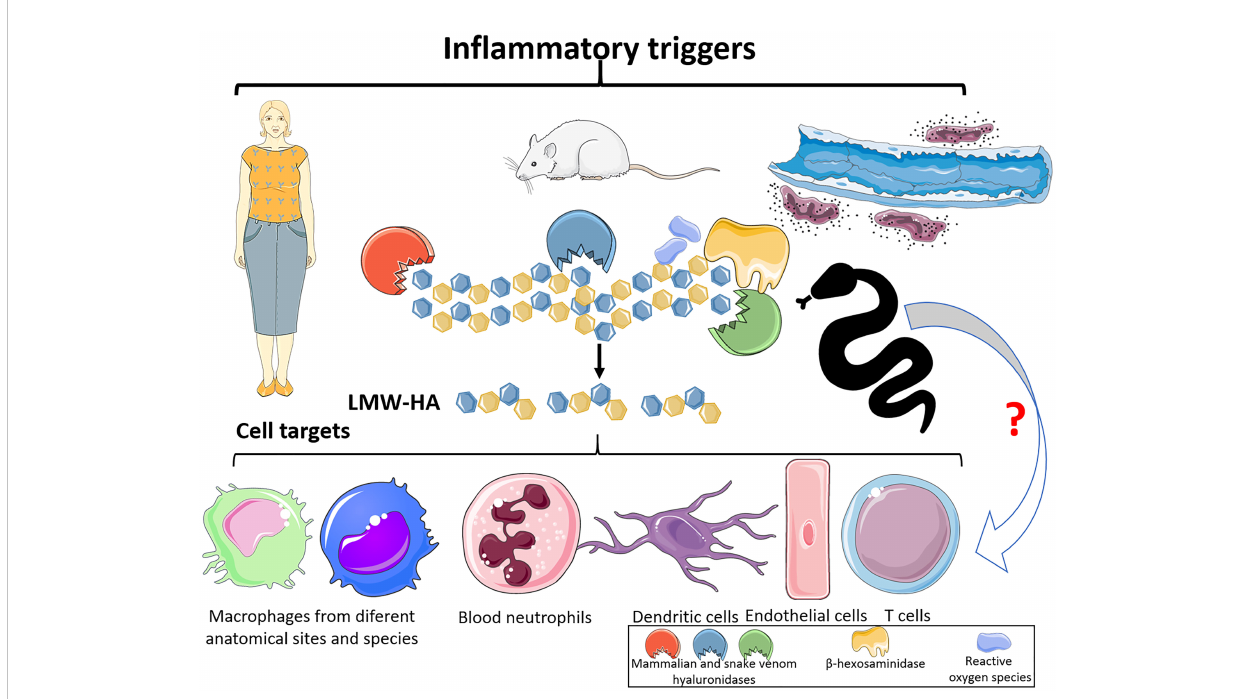
FIGURE 3 Hyaluronan fragmentation and its targets. After mammalian tissue and organ dysfunctions, elicited by diverse pathological conditions, hyaluronidases, b-hexosaminidases and ROS are released. These molecules can promote the cleavage of high molecular weight polymeric hyaluronan and generate tetra and hexasaccharide fragments (LMW-HA). These LMW-HA fragments function as DAMPs, which can be sensed by immune cells, via Toll Like Receptors -2 and -4. This event can lead to the production of interleukins, chemokines, and lipid mediators, leukocytes in fi ltration, as well as tissue damage. Hyaluronidases from snake venoms, as the mammalian molecules, can also act upon hyaluronan and release tetra and hexasaccharide fragments, which suggests that snake venom hyaluronidases can be potent inducers of in fl ammatory events via